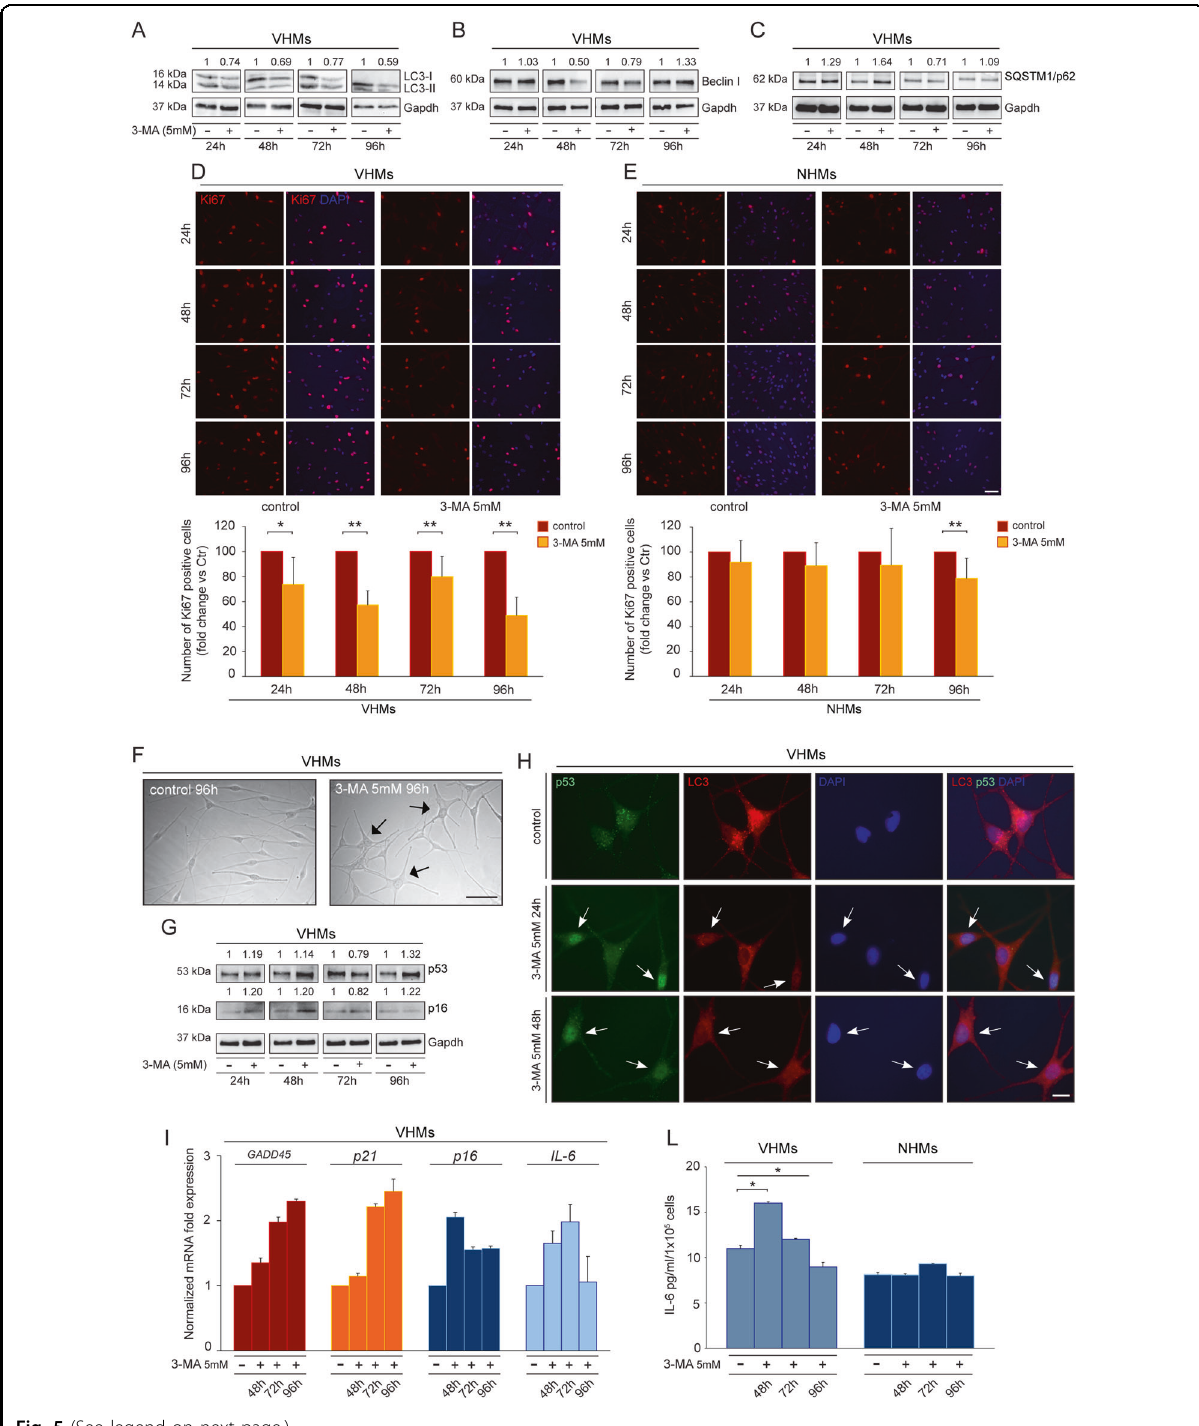
Fig. 5 (See legend on next